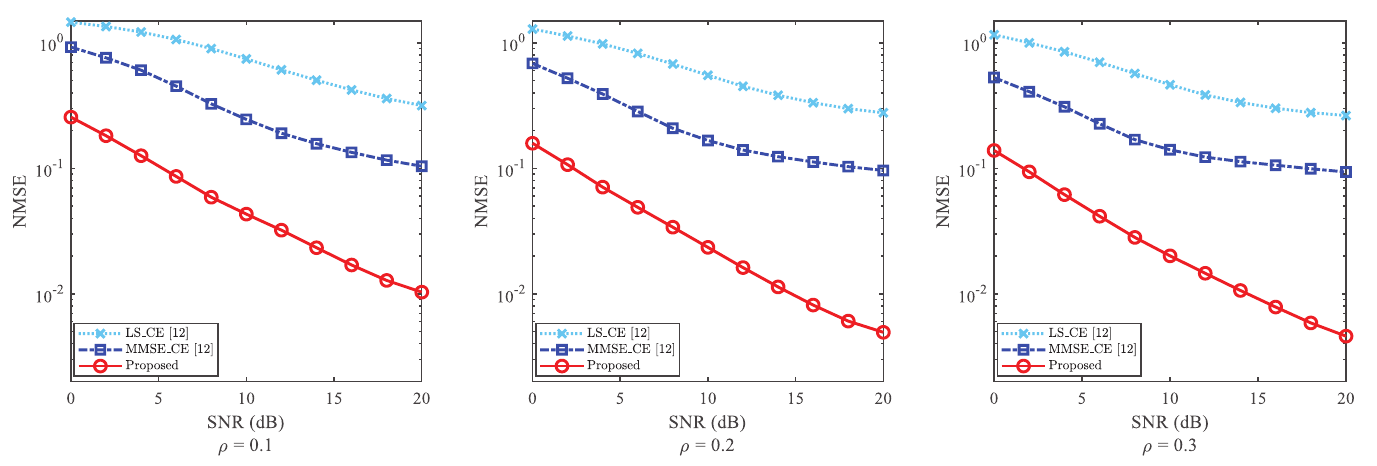
Fig 7. NMSE of CE against the impact of ρ , where ρ = 0.1, ρ = 0.2 and ρ = 0.3 are considered, respectively.